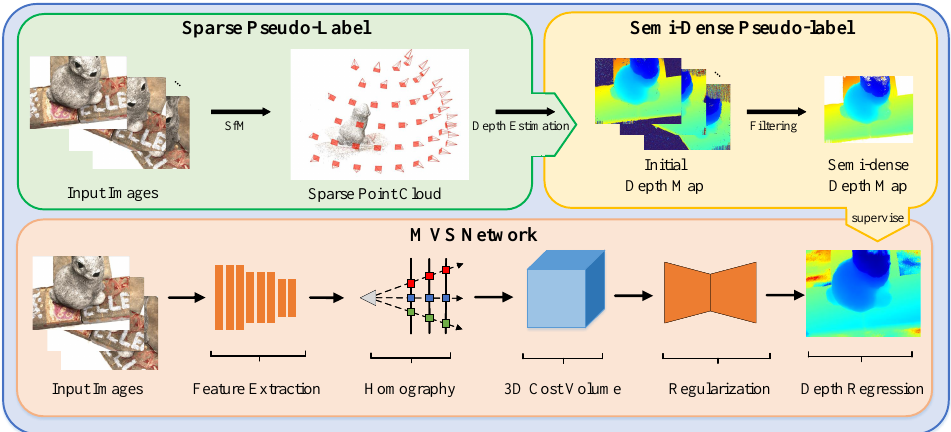
Figure 1. Geometric prior-guided self-supervised learning MVS framework. We generate the sparse and semi-dense pseudo-labels by using SfM and the traditional MVS method. These labels are then used to supervise the training of our MVS network.